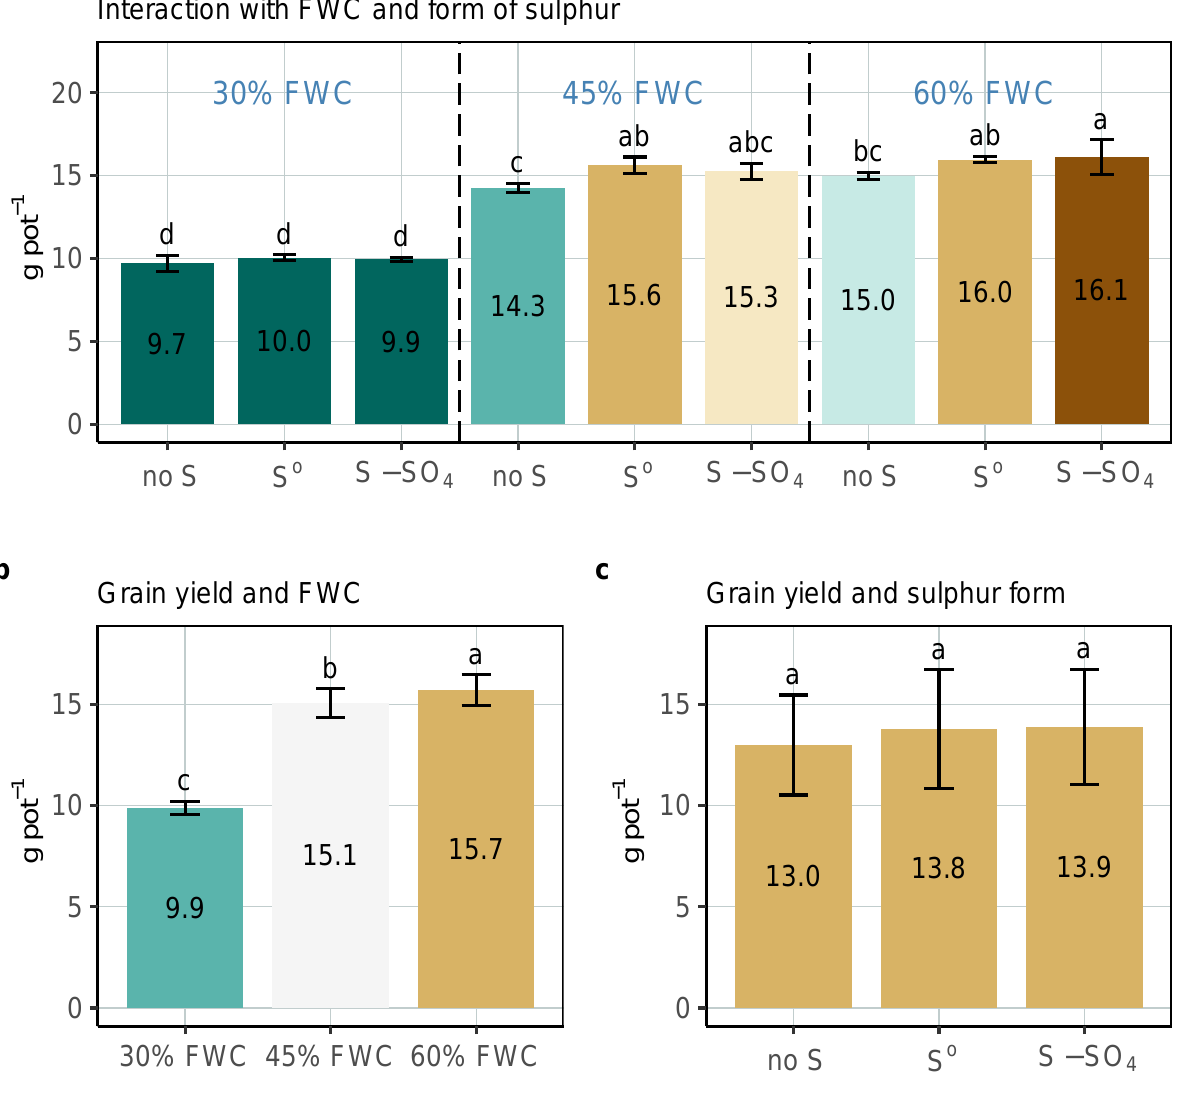
Figure 1. Grain yield of spring wheat. Values indicated by the same letter are not significantly different ( α =